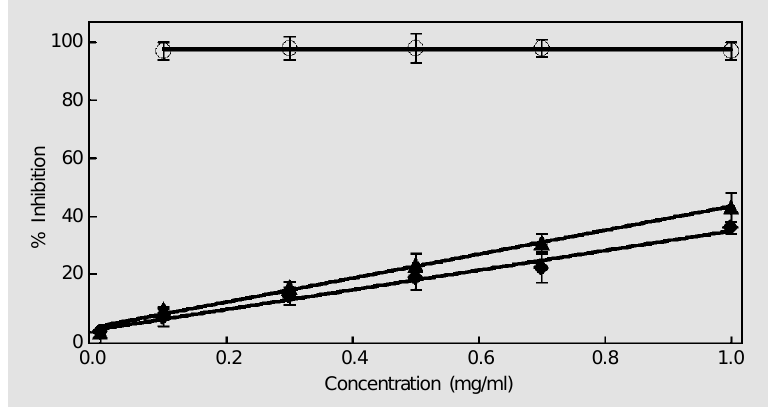
Figure 4. Inhibitory effect of Polypodium leucotomos extract (triangles) and kojic acid (lozenges) (0.0 to 1.0 mg/ml) on singlet oxygen detected by bleaching of n,n-dimethyl-4- nitroso-aniline. Azide (circles) was used as